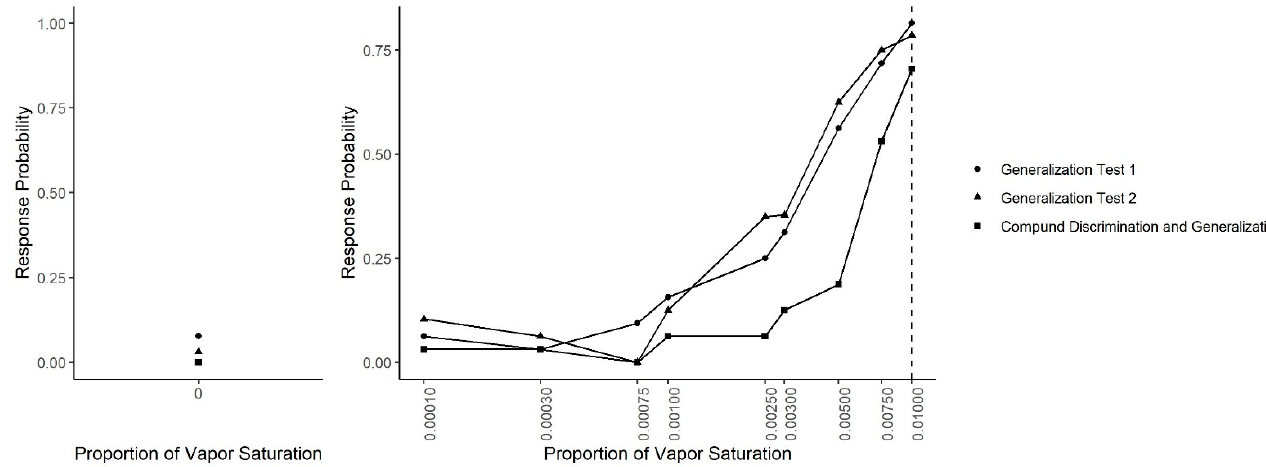
Figure 8. Generalization across all tests. The spontaneous generalization to a range of air dilutions of the trained odorant (0.01; dashed line) for Generalization Test 1, Generalization Test 2 and Compound Discrimination and Generalization: ( Left ) the response to a clean air stimulus; and ( Right ) the range of concentrations on a log scale.